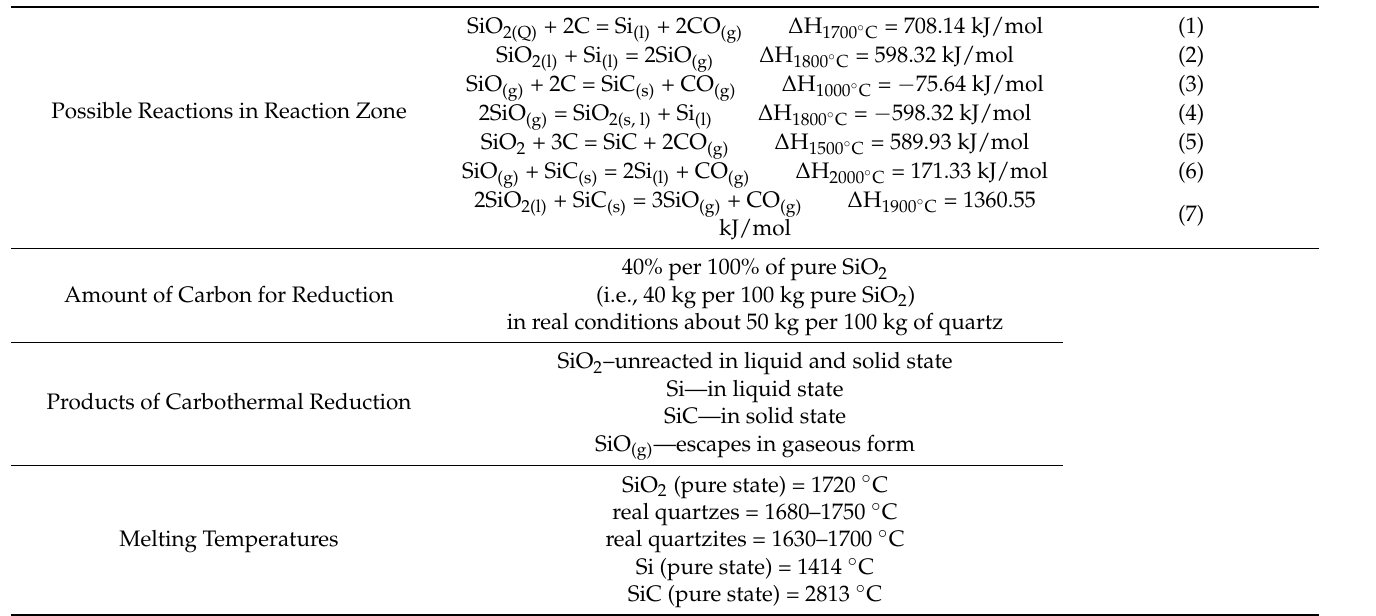
Table 2. Basic information on carbothermic reduction